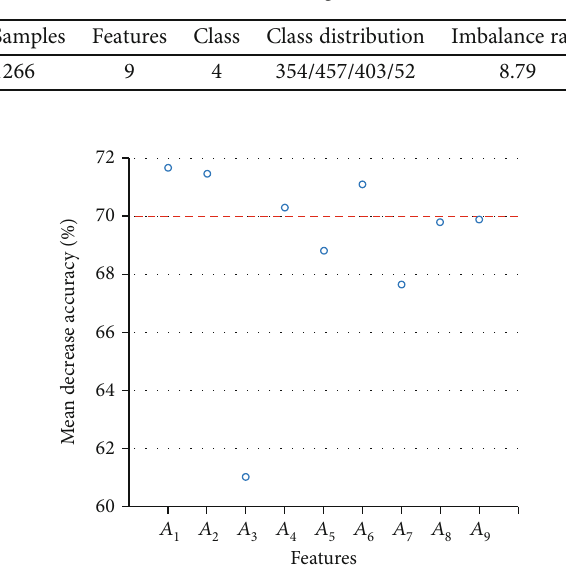
Table 2: Details of original data sets.